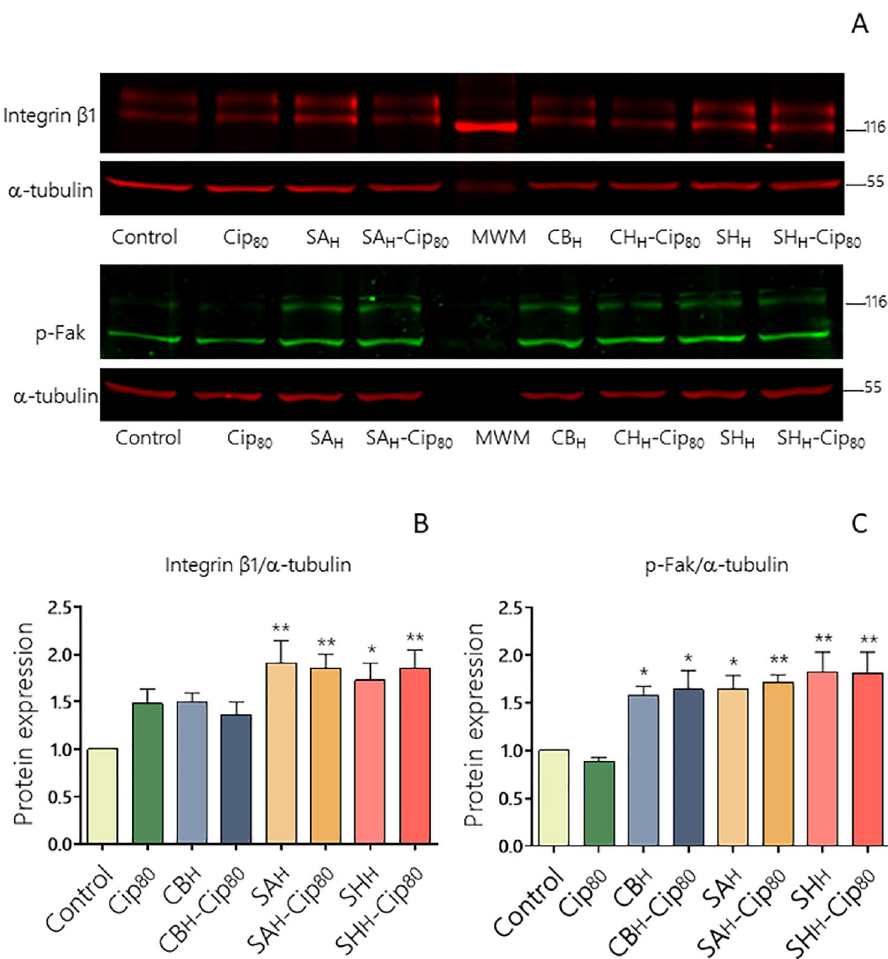
Figure 4. Effect of Cip, PE or PE-Cip complexes on integrin β1 and p-FAK protein expression. ( A ) Protein expression was analyzed by Western blot assays from cell lysates (100 µg/lane) of HDF-treated cells electrophoresed on a 7.5% SDS-PAGE and transferred to a nitrocellulose filter. Filters were incubated with anti-integrin β1, anti-p-FAK or anti-α-tubulin antibodies. Representative blot of three independent experiments with similar results is shown. Cropped blots from different parts of the same gel are separated by white spaces. ( B , C ) The bar graphs represent the densitometric quantification of protein levels in treated cells normalized to α-tubulin of three separate experiments compared to the corresponding normalized protein levels in control cells defined as 1 (mean ± SEM). Differences in treatments were evaluated using ANOVA with Dunnett’s post- test *p < 0.05; **p < 0.01. Plotted with GraphPad Prism v.7.00 software (GraphPad, USA, https:// www. graph pad.